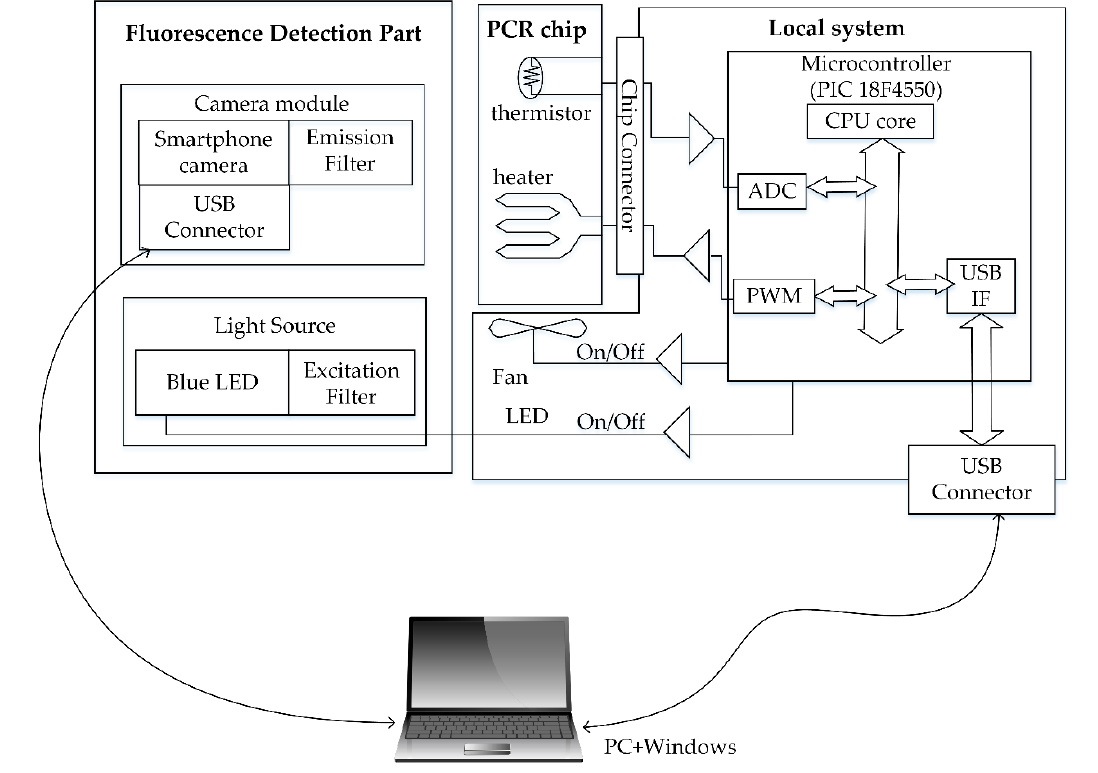
Figure 2. Block diagram of proposed RT-PCR system.